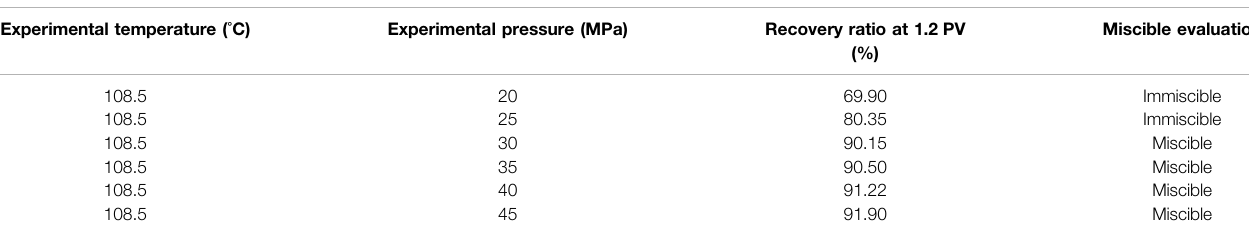
TABLE 4 | The long-slim-tube displacement experiment results of crude oil for injecting CO 2 . Experimental temperature ( °